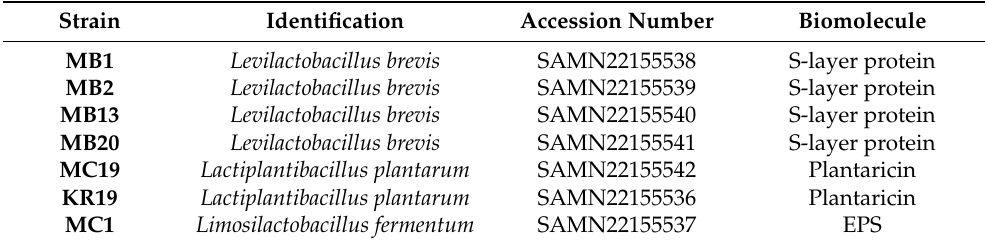
Table 4. Accession numbers of identified LAB strains, potential producers of the therapeutic